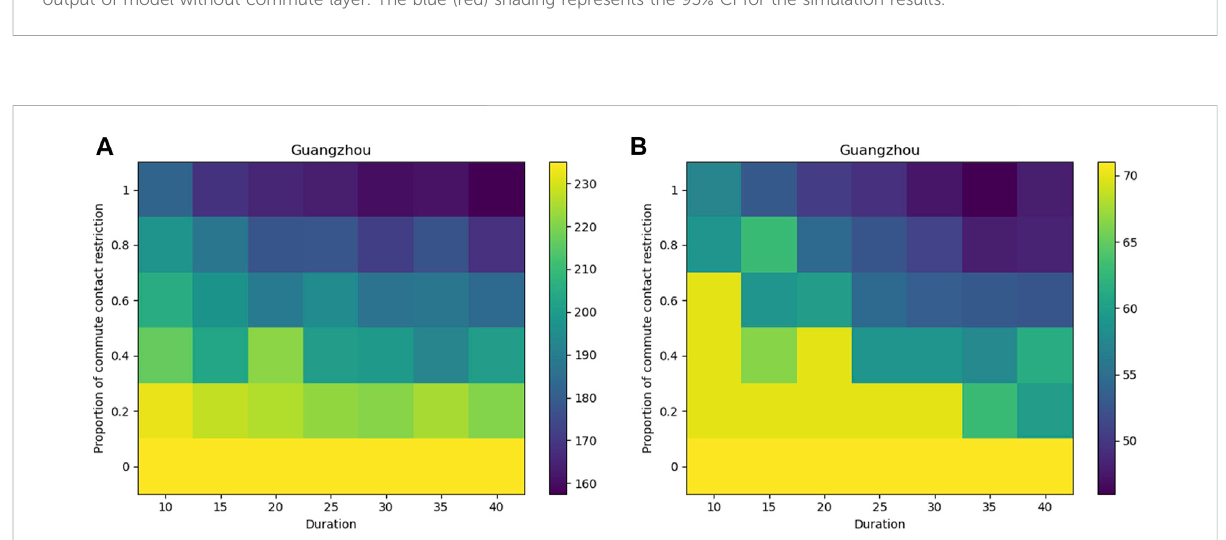
FIGURE 4 Output of model with and without commute layer. Blue curve shows the predictions from the model with commute layer and red curve is the output of model without commute layer. The blue (red) shading represents the 95% CI for the simulation